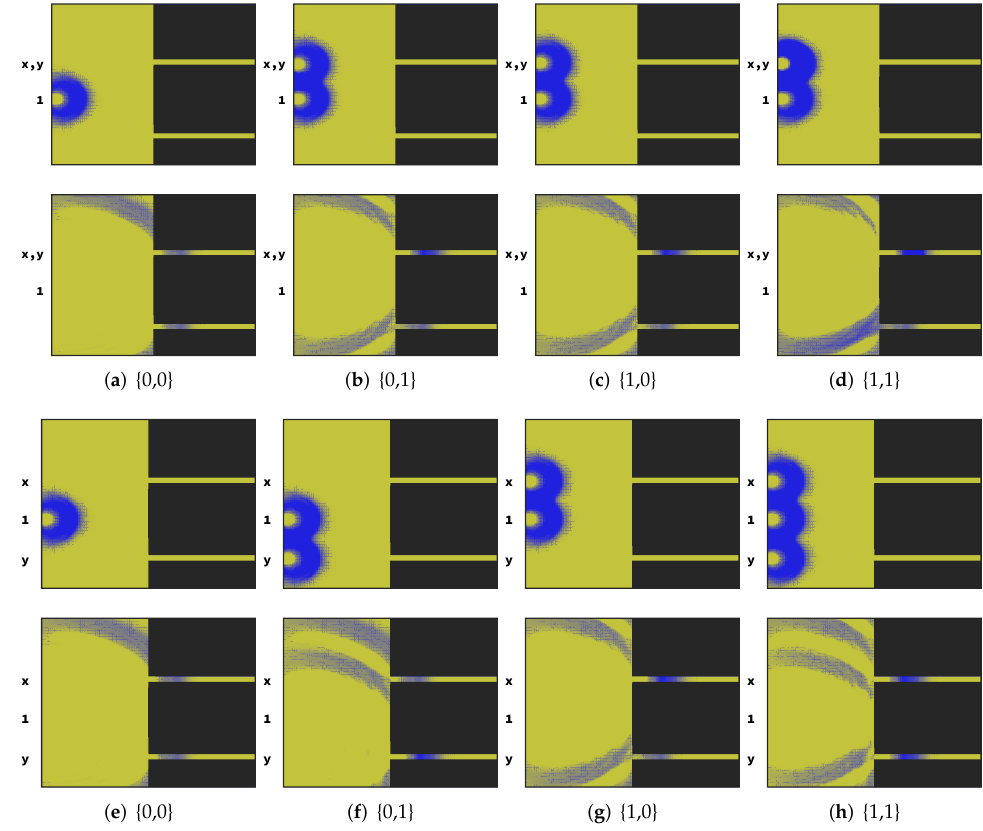
Figure 11. Examples for NOR ( a – d ) and XNOR ( e – h ) gates geometries for the input ( top ) and result ( bottom ) frames of the wave propagation for each possible input { x , y }